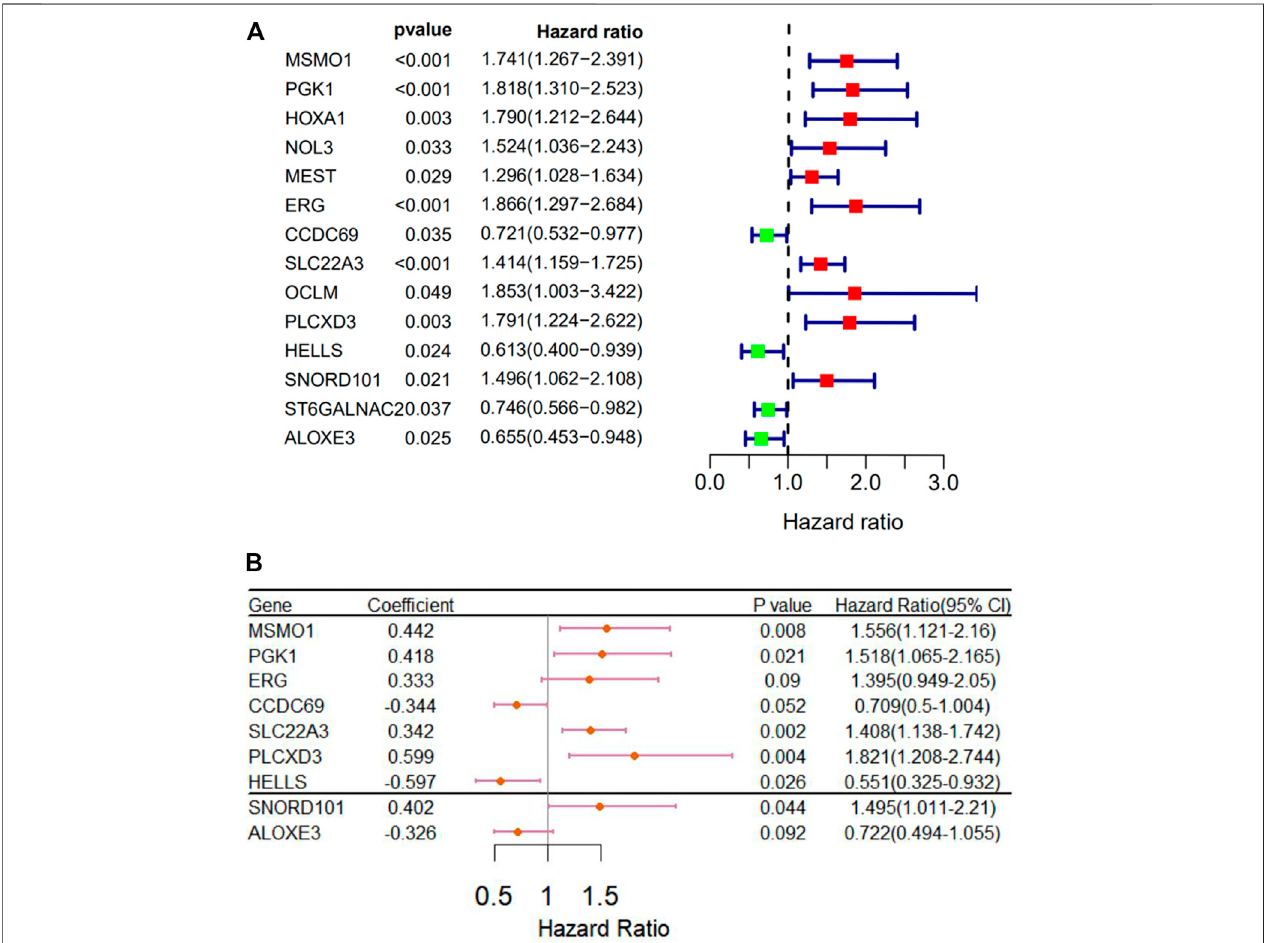
FIGURE 6 | Re-diagnosis of MSMO1 on the prognosis of CESC. (A) Forest map of univariate analysis. (B) Forest map of multivariate Cox regression analysis.